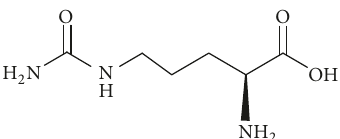
Figure 1: Molecular structure of L-citrulline (175.2 g/mol).